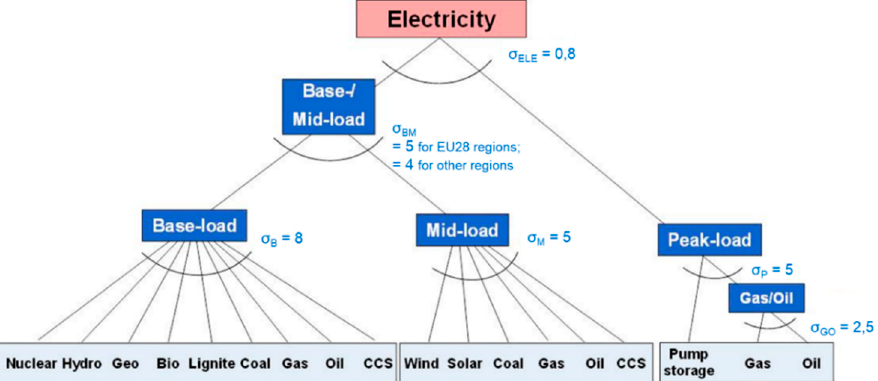
Figure A2. NEWAGE disaggregation of electricity generation.